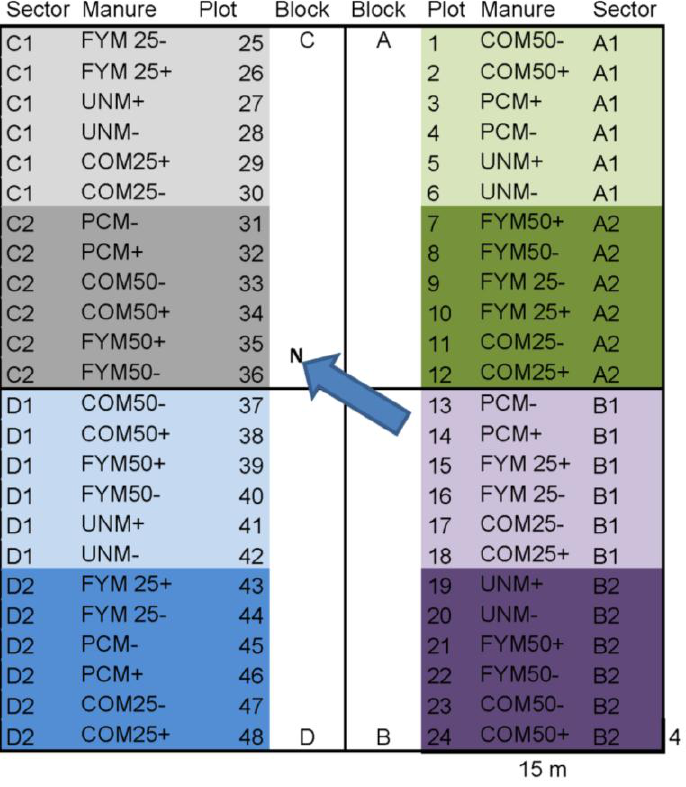
Figure 1. Design of field trial at Skilleby Research Farm 2006, coloured according to sectors used in data analysis. FYM = fresh farmyard manure, COM = composted farmyard manure, PCM = pelleted chicken manure, 25.50 t/ha, +/− = with/without biodynamic preparations.